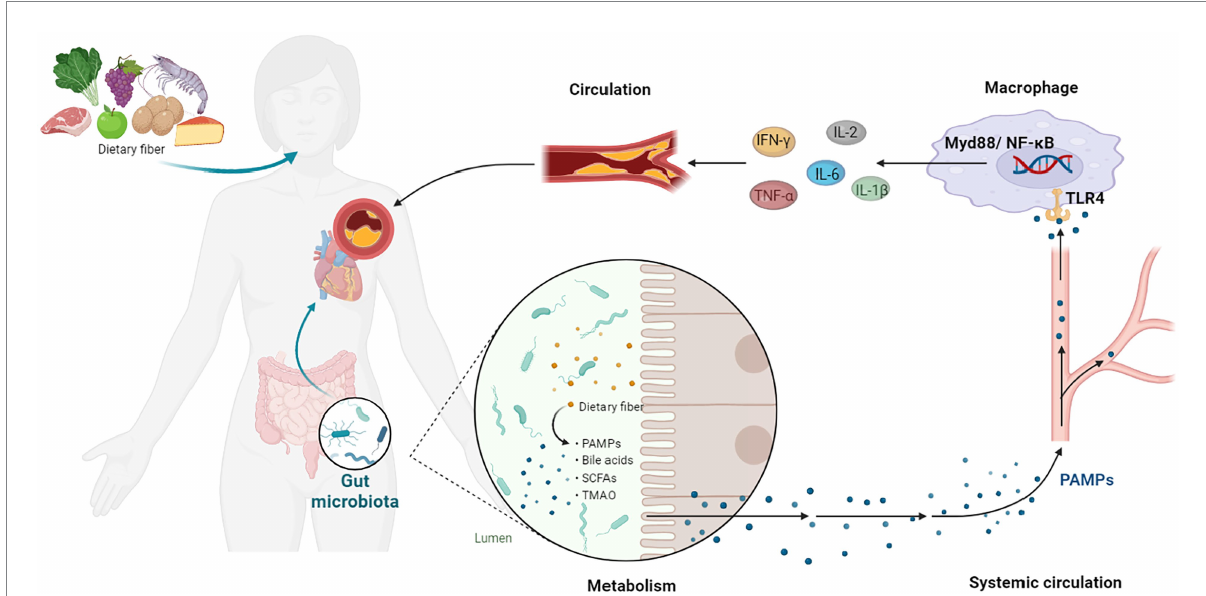
FIGURE 1 GM-Inflammation axis in AS. PAMPs, pathogen-associated patterns; TLR4, Toll-like receptor 4; NF- κ B, NF-kappa B; TNF- α , tumor necrosis factor- α ; IL, interleukin; IFN- γ , interferon- γ .